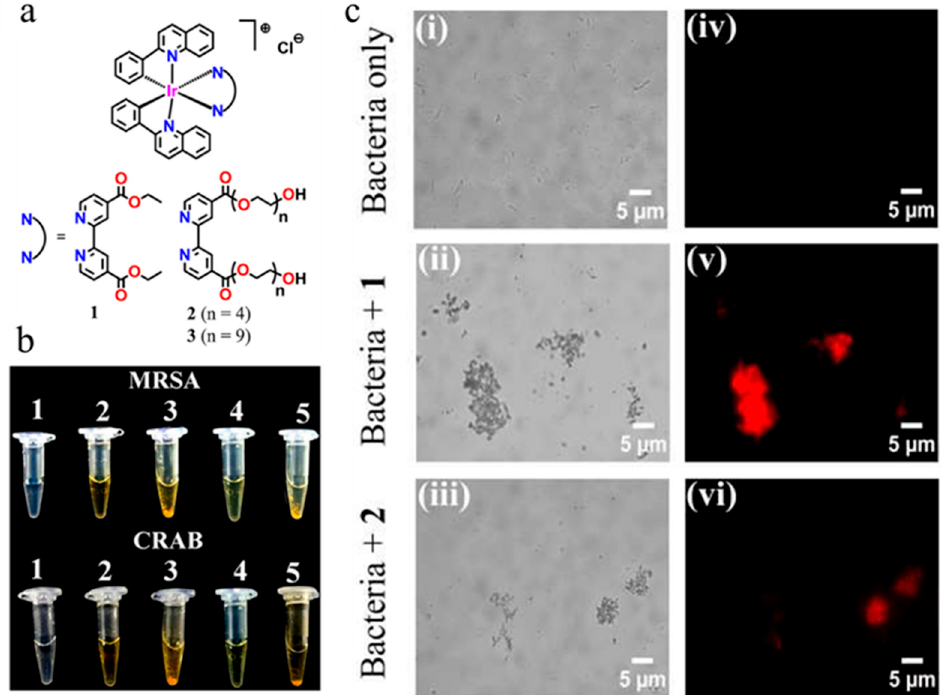
Figure 20. ( a ) Structures of cyclometalated Ir(III) complexes ( 1 − 3 ). Rapid bacterial agglutination test in spiked water samples visualized by ( b ) the naked eye and ( c ) optical microscopy. In ( b ), 10 8